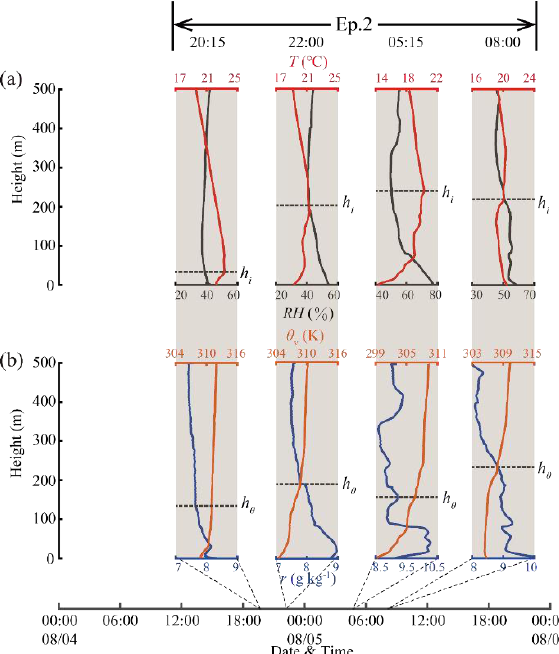
Figure 10. Variations in the vertical profiles of the ( a ) temperature ( 𝑇 , red solid line) and relative humidity ( 𝑅𝐻 , black solid line) and the ( b ) virtual potential temperature ( 𝜃 v , orange solid line) and water vapor mixing ratio ( 𝑟 , blue solid line) from 00:00 LST on 04 August 2020 to 00:00 LST on 06 August 2020 during Ep. 2. Four times (20:15 LST; 22:00 LST; 05:15 LST; 08:00 LST) were chosen (brown background). The horizontal dotted lines in ( a ) indicate the heights of the inversion layer ℎ 𝑖 , and those in ( b ) indicate the heights ℎ 𝜃 where the 𝜃 v value first exceeds the minimum 𝜃 v value by 1.5 K.